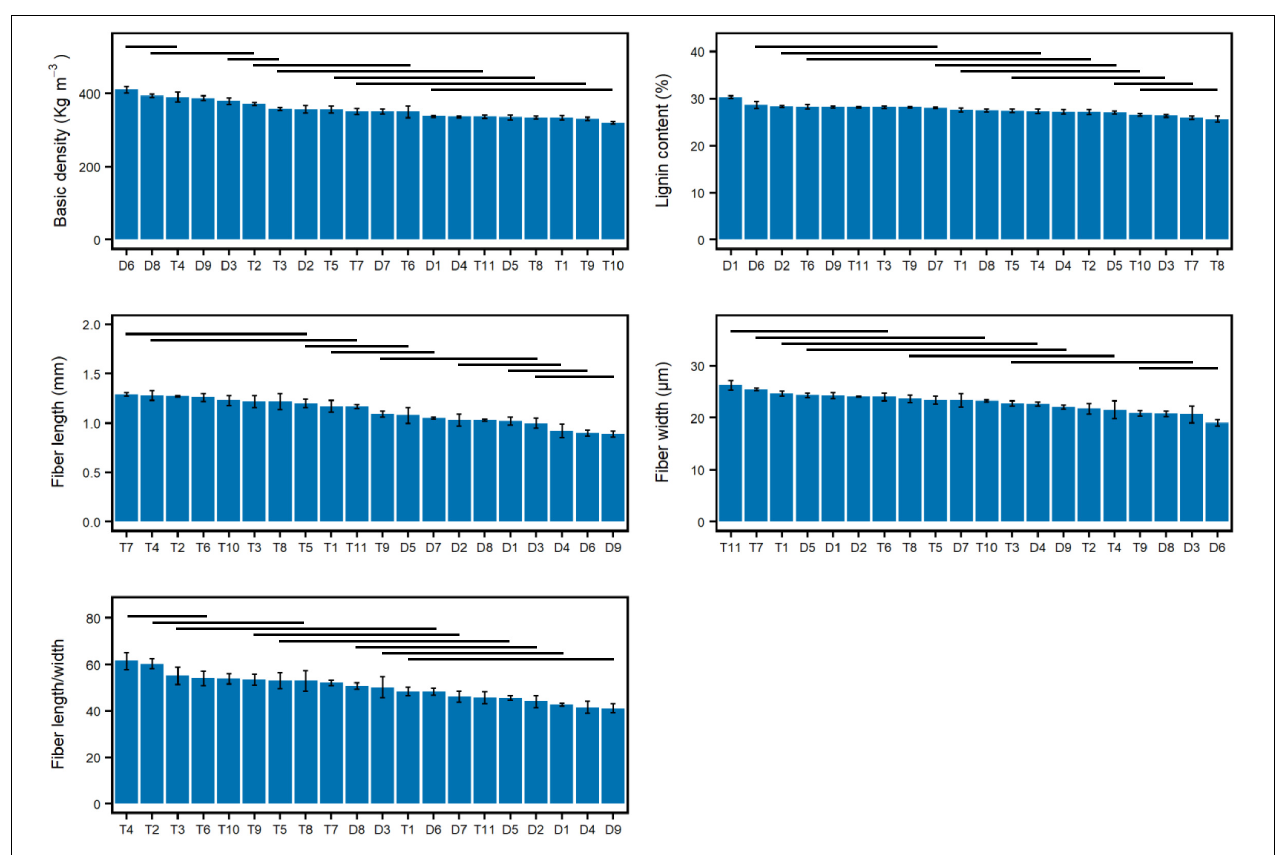
FIGURE 1 | Comparison among the genotypes for the measured wood and fiber traits. “—” covers the genotypes without a significant difference at the 0.05 level.